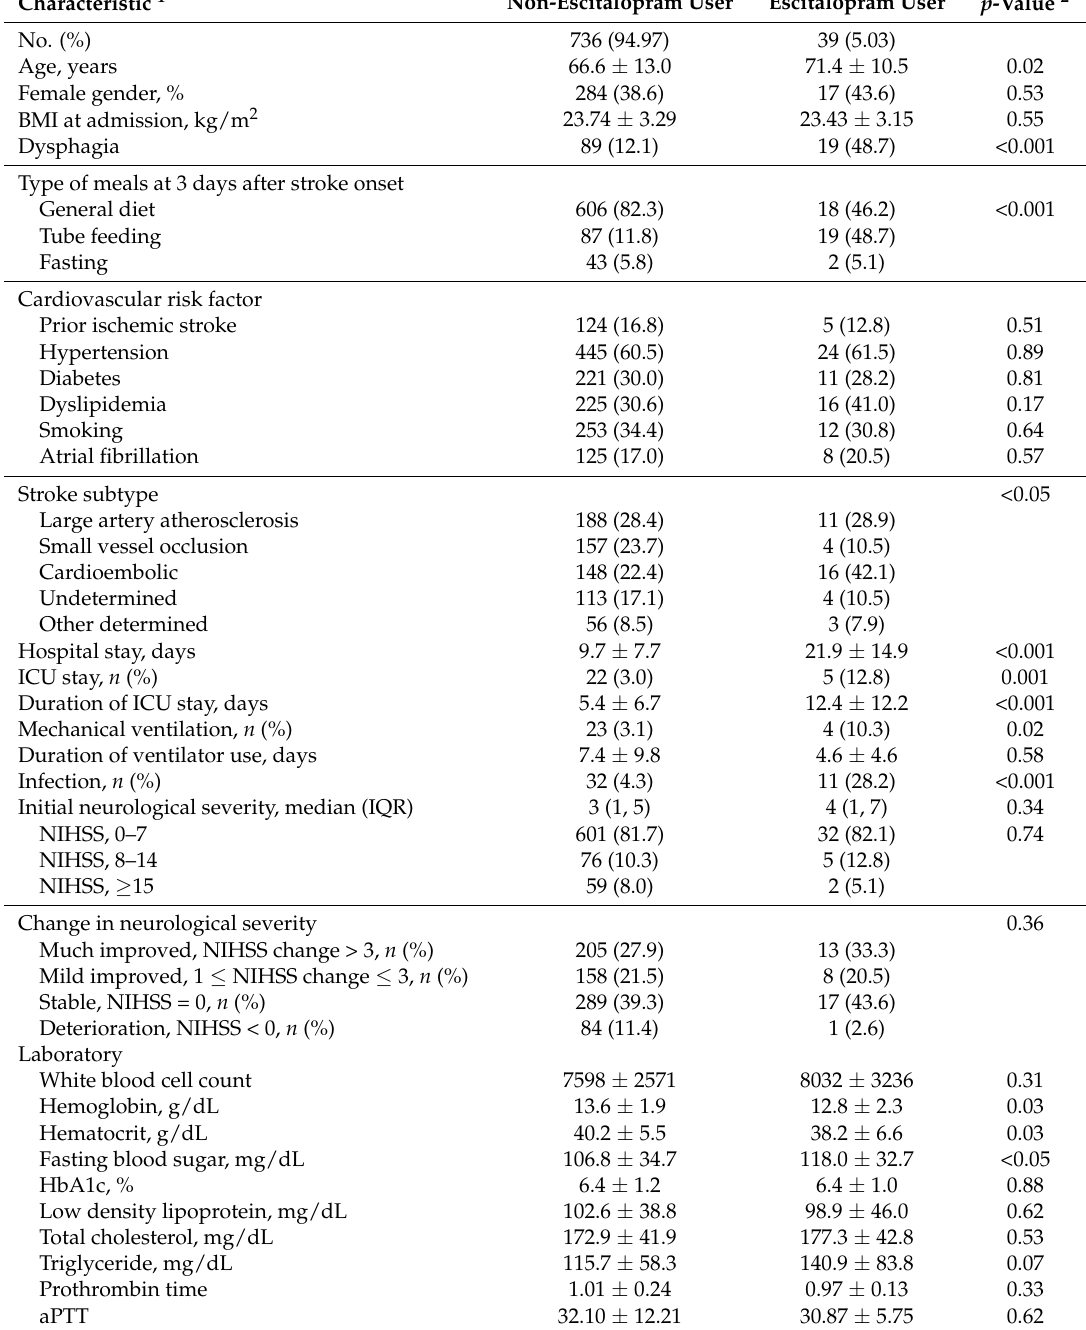
Table 1. Baseline characteristics and the differences between escitalopram users and